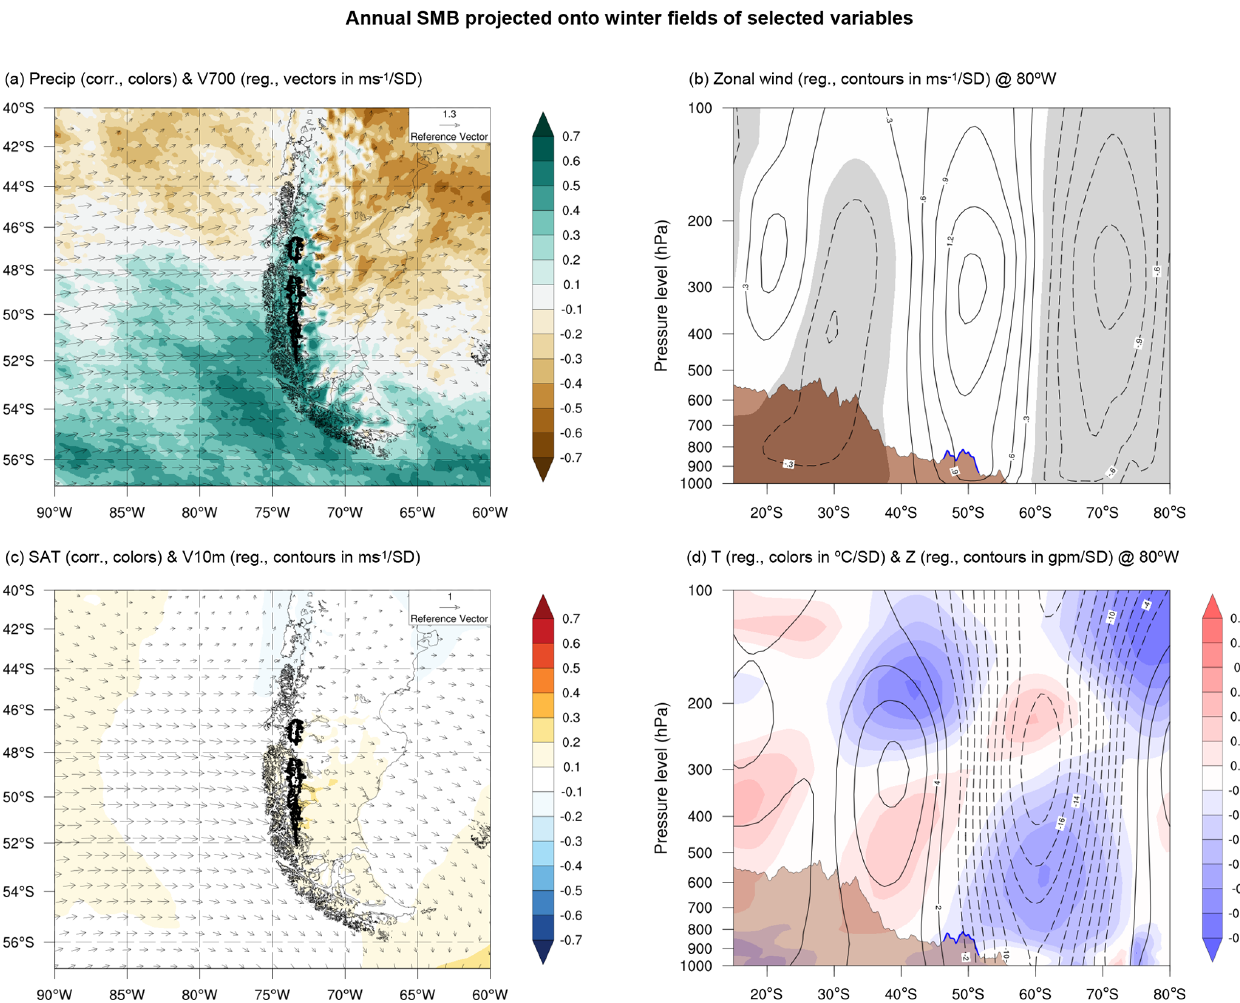
Figure 6. The same as in Fig. 5 but for the winter (April to